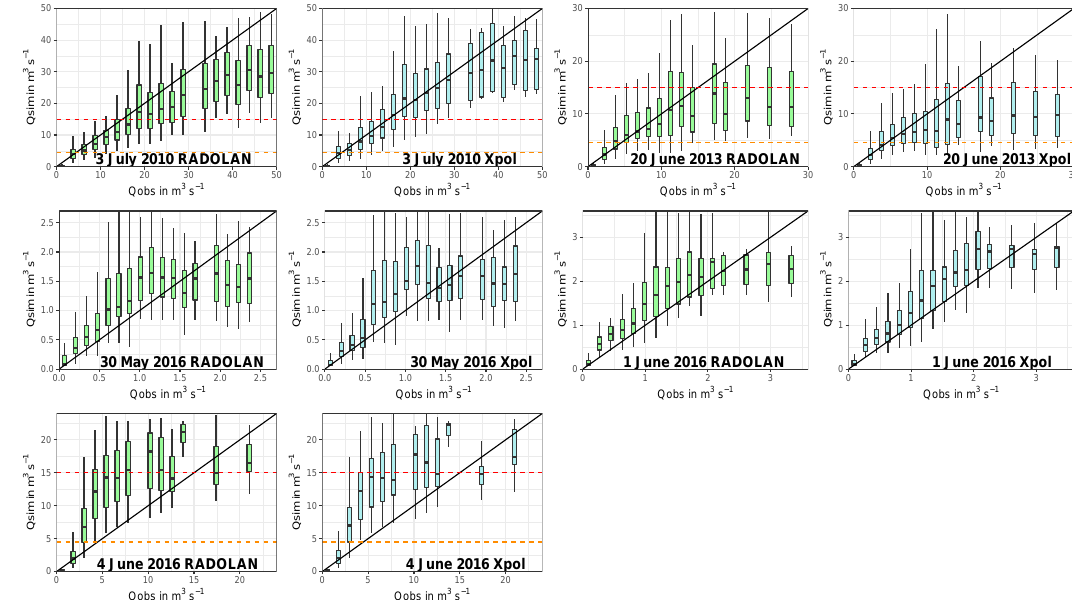
Figure 5. ParFlow hindcast discharge uncertainty results, where Q is the discharge in m 3 s − 1 . Ensemble simulations forced with RADOLAN and XPol are organized into equidistant bins according to event (3 July 2010: 2.5 m 3 s − 1 ; 20 June 2013: 1.5 m 3 s − 1 , 30 May 2016: 0.135 m 3 s − 1 , 1 June 2016: 0.18 m 3 s − 1 , 4 June 2016: 1.2 m 3 s − 1 ). Outliers are not shown. The solid line represents a perfect fit between simulation and observation. The orange dashed line indicates a discharge level 1 at 4.5 m 3 s − 1 and the red line indicates a discharge level 2 at 15 m 3 s − 1